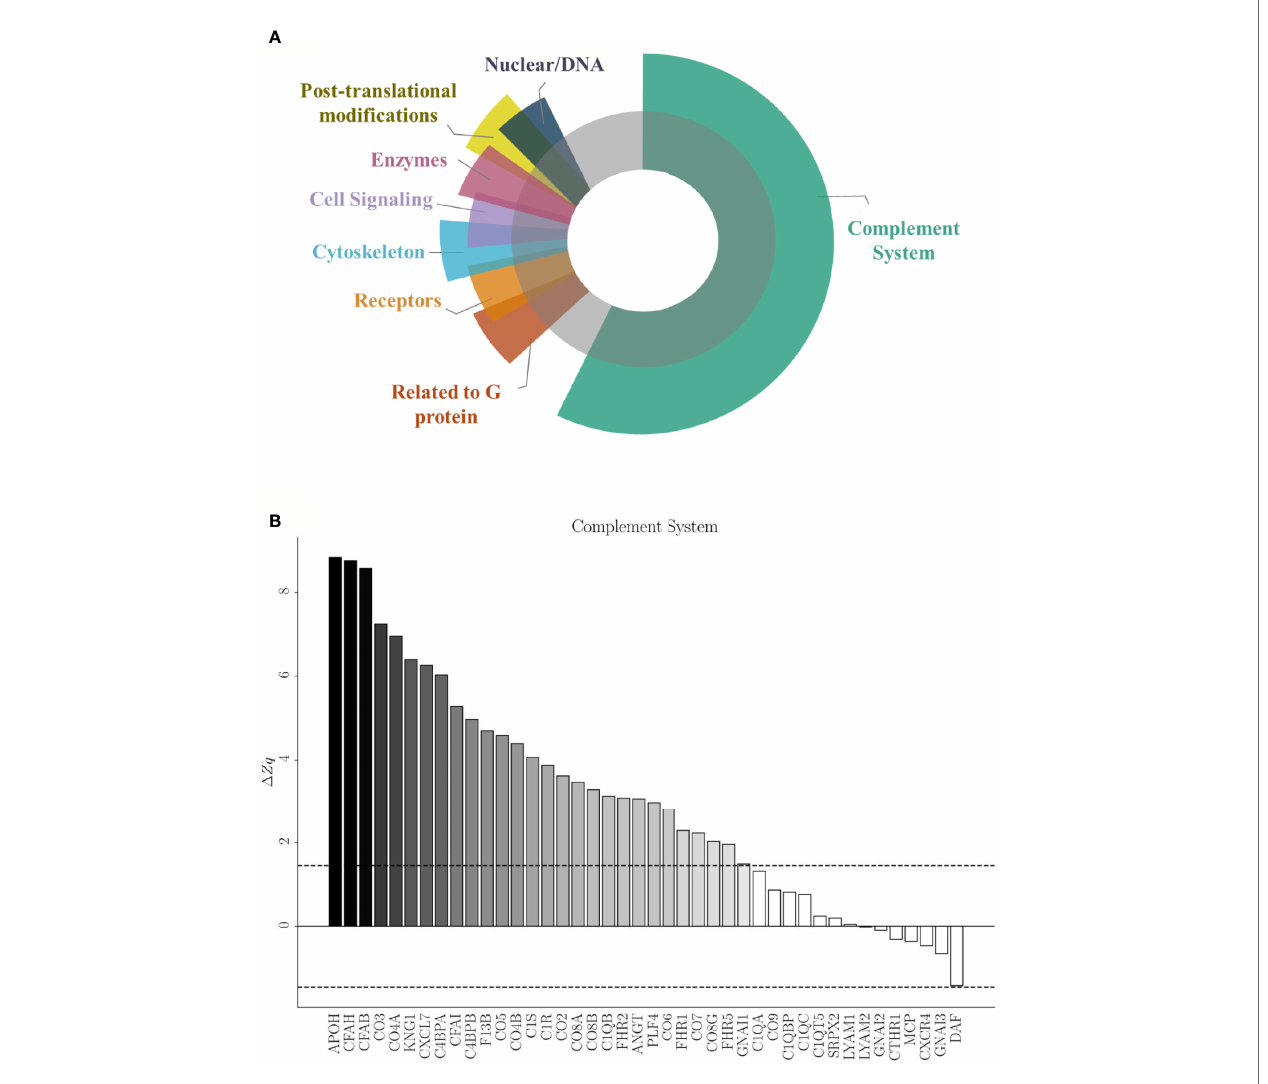
FIGURE 6 | Speci fi c protein variation contributing to complement system alteration in EC-anaphylaxis. (A) Main altered functional categories in EC-anaphylaxis. (B) The graphic represents the list of proteins identi fi ed in relation with the complement system and their speci fi c D